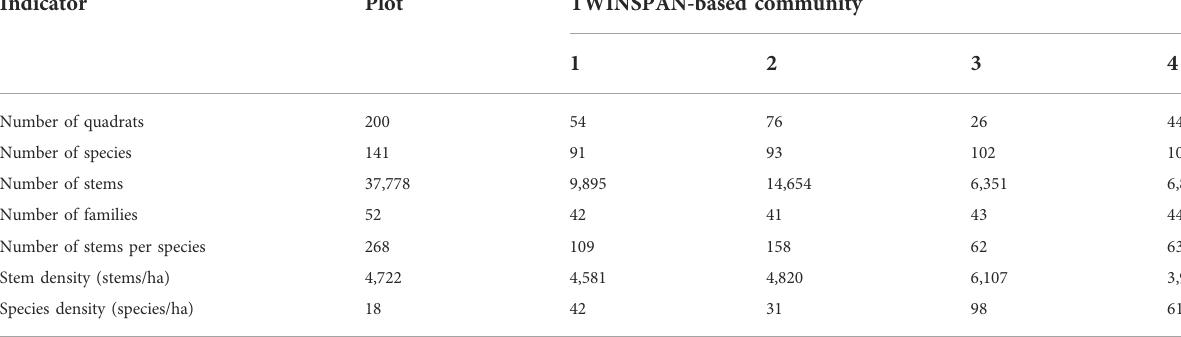
TABLE 1 | Species composition of the woody plants (DBH ≥ 1 cm) in the sample plot and forest communities. The values of number of stems per species, stem density, and species density have been rounded to whole numbers. Indicator Plot TWINSPAN-based